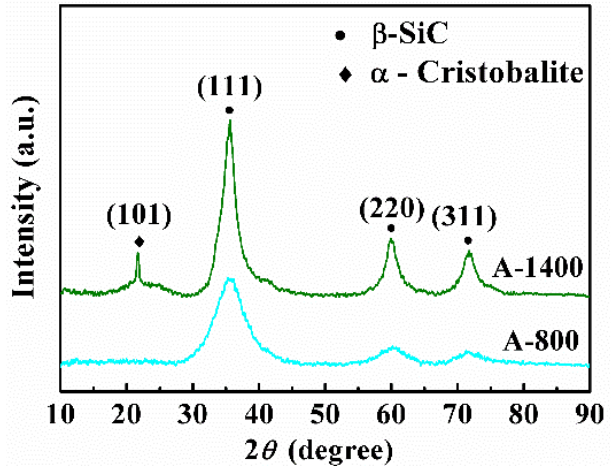
Figure 6. XRD patterns of the 2.5D SiCf/SiCm composites under different treatment conditions.